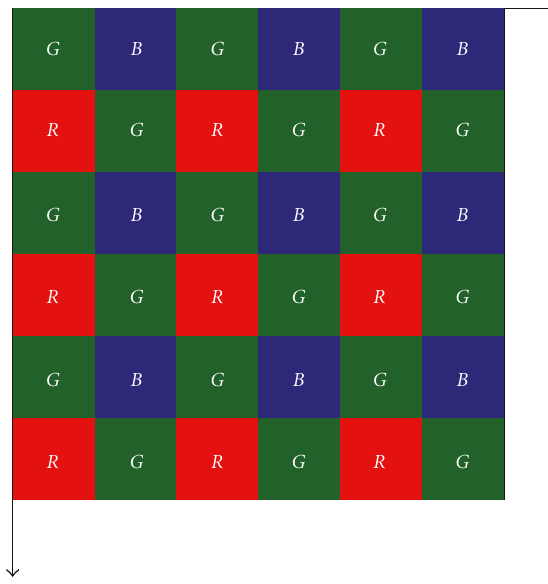
Figure 1: The Bayer